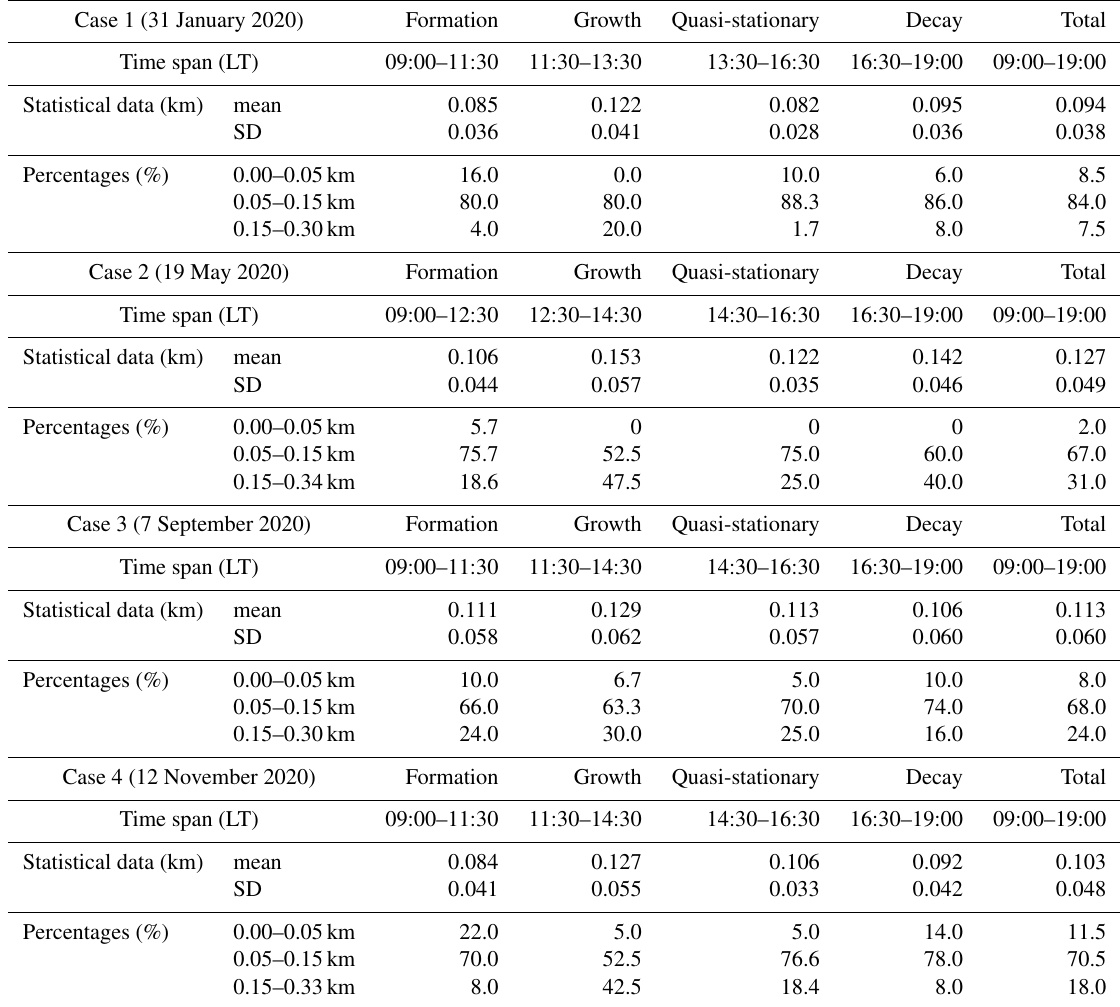
Table 3. Comparison of the EZT statistics for the four typical